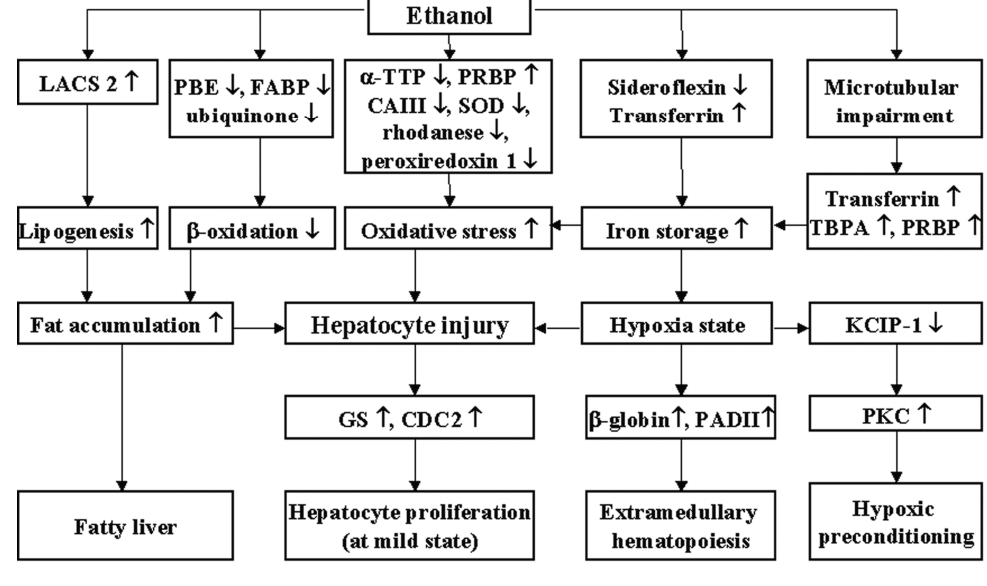
Figure 4. The illustration of proposed changes in cytoplasmic proteins